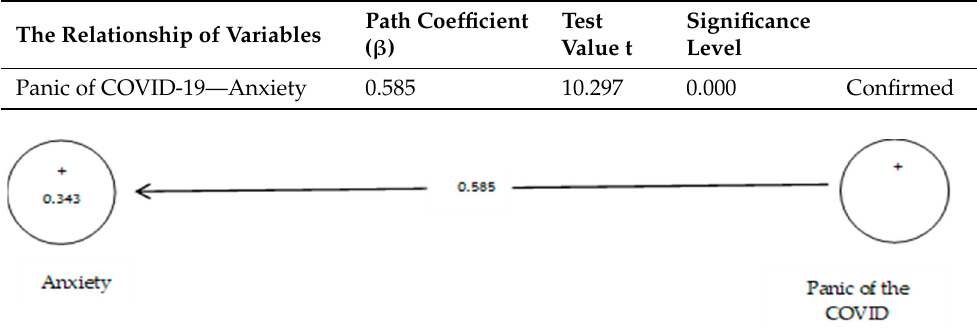
Figure 18. The eighth sub-hypothesis model includes factor load coefficients.